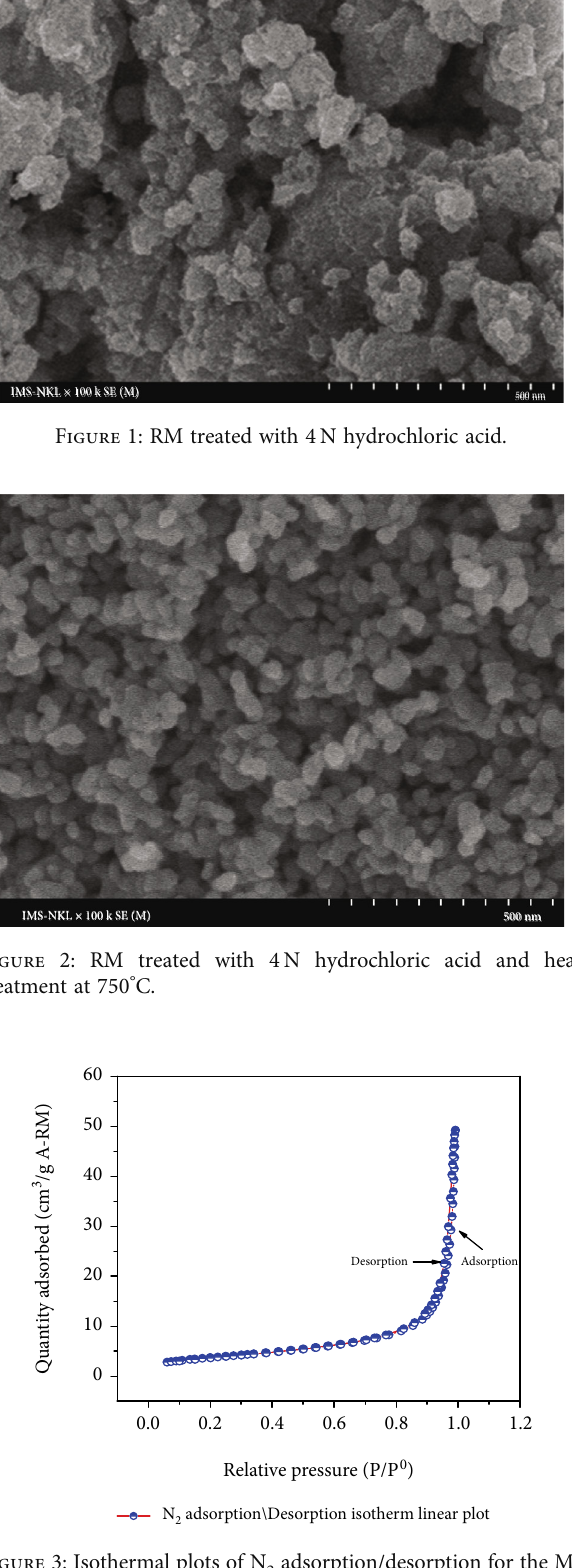
adsorption/desorption for the M- 2